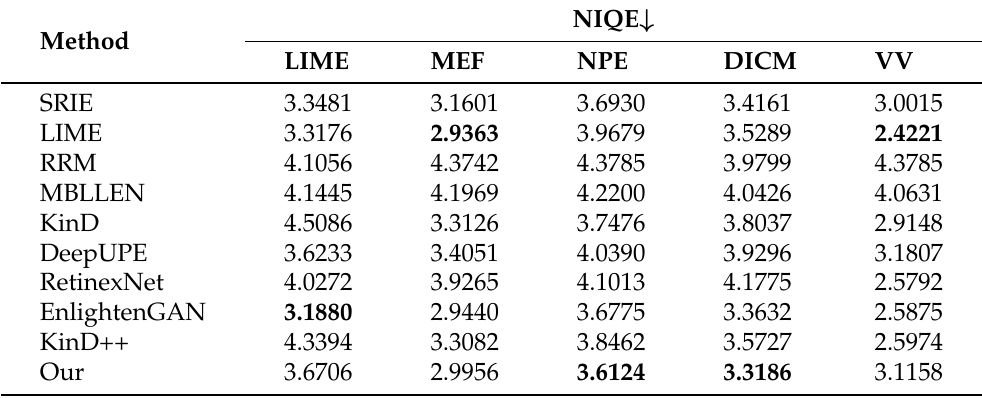
Table 3. Quantitative evaluation with NIQE metric on LIME, MEF, NPE, DICM, and VV datasets. The best results are in